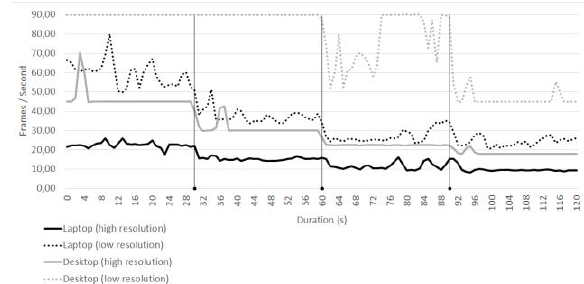
Figure 7. The attained framerate for the two different systems, on two rendering resolutions (100% and 20%). The approximate times for switching on additional lights in the scene are marked at 30, 60 and 90 seconds. As the amount of lights using dynamic shadows and illumination increases, the rendering performance drops.